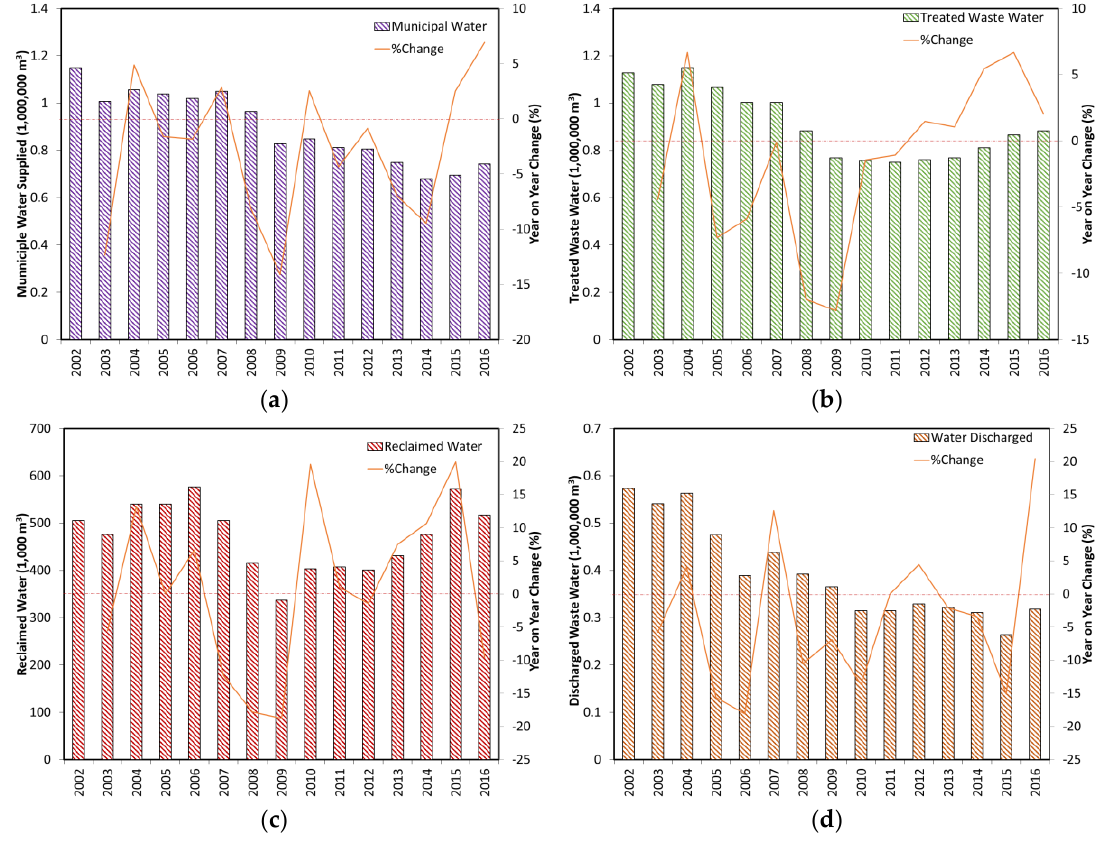
Figure 4. The total annual water quantities at KIX during 2002–2016 and the year-on-year change (%): ( a ) municipally supplied, ( b ) treated, ( c ) reclaimed, and ( d ) discharged. Source: data derived from